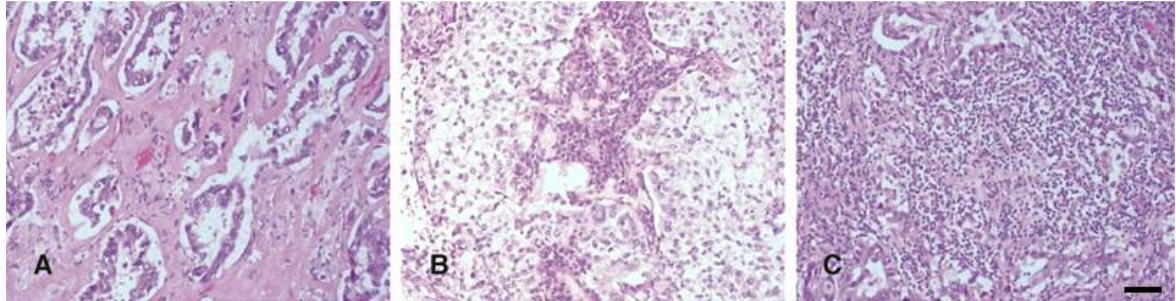
Figure 2. Immune microenvironment response in the tumour: predominantly absent ( A ), low ( B ), or high ( C ). Scale bar 25 µm.